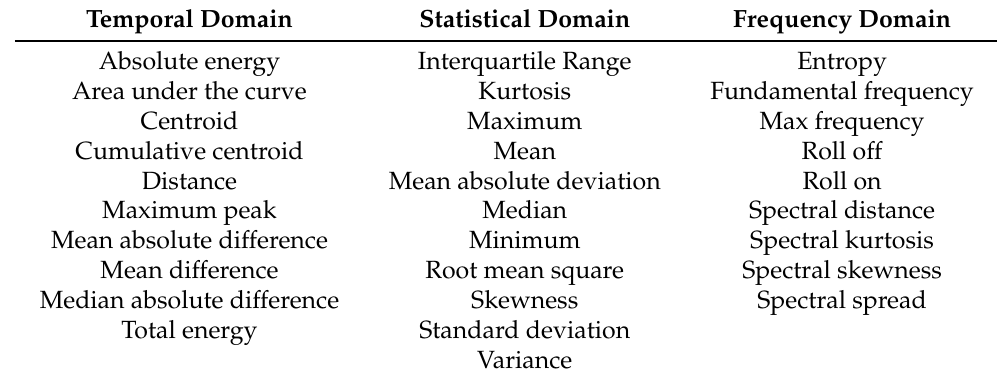
Table A1. Features applied in this work for creating the SSMs. The Time Series Feature Extraction Library (TSFEL) is utilized for feature extraction.